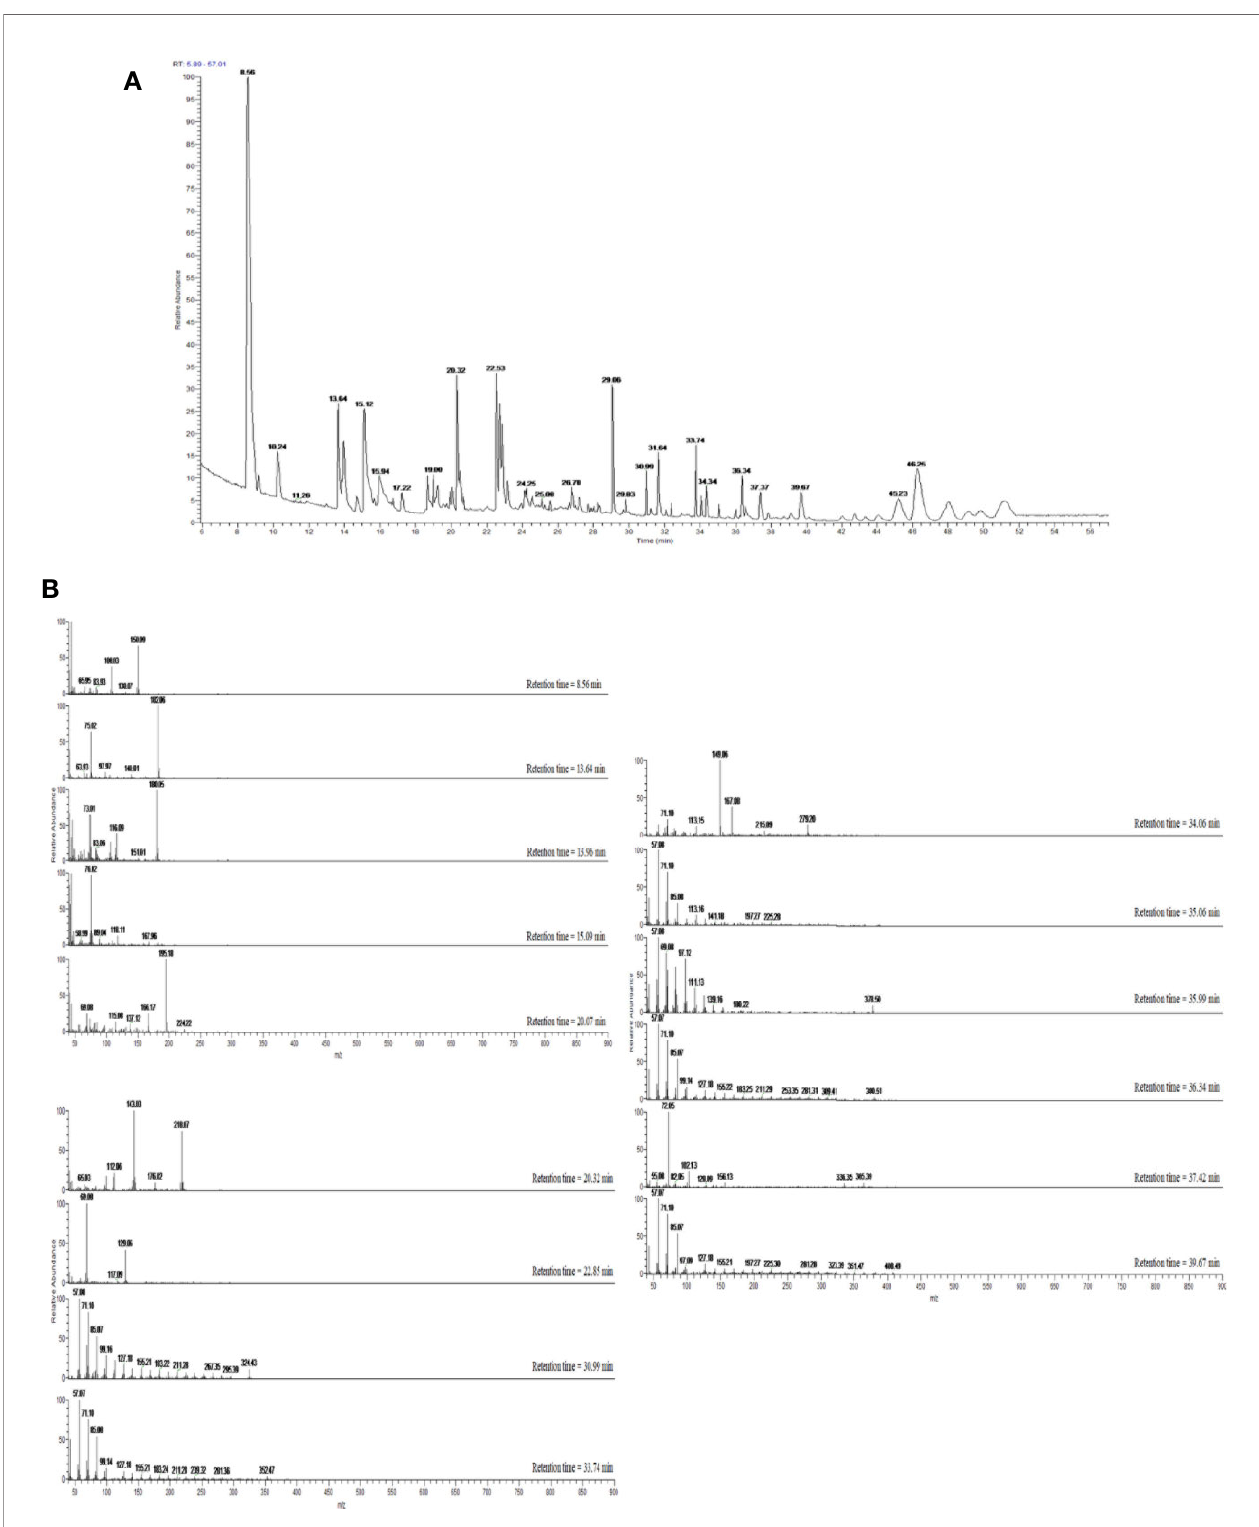
FIGURE 2 | (A) GC – MS total ion chromatogram (TIC) of OBE. Peaks were identi fi ed through comparison with mass spectral data in the NIST MS Search 2.0 library stored in the GC – MS system and are represented in Table 1 . (B) Mass spectra of compounds eluted with retention times 8.56 – 46.25 min and presented in Table 1